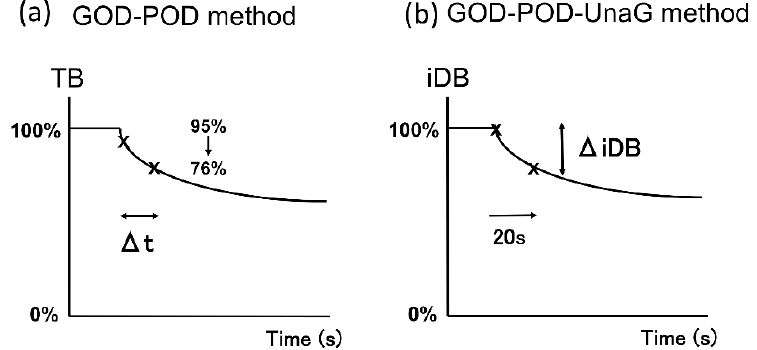
Figure 5. Calculation method of UB using estimated initial velocity of the GOD–POD and GOD–POD–UnaG methods. ( a ) In the GOD–POD method, the UB value is calculated by estimating the initial velocity based on the time taken for TB to reduce by 20% ( ∆ t). ( b ) In the GOD–POD–UnaG method, the UB value is calculated based on the rate of reduction of iDB ( ∆ iDB) over 20 s. GOD, glucose oxidase; iDB, indirect bilirubin; POD, peroxidase; UB, unbound bilirubin; UnaG, bilirubin-inducible fluorescent protein from eel muscle.